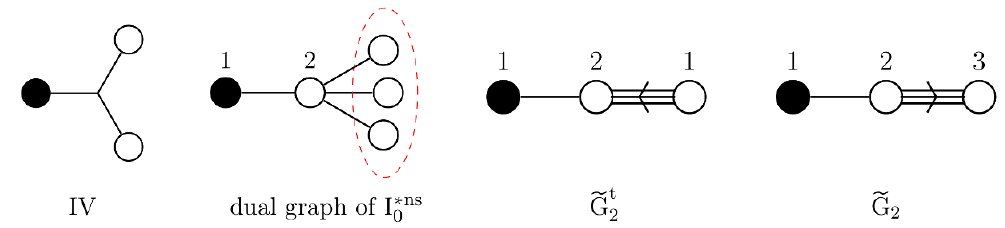
Figure 2 . Conventions for dual graphs. The black node represents the extra node of the a(cid:14)ne Dynkin diagram. The a(cid:14)ne Dynkin diagrams e G 2 and e G t e G t 2 is the dual graph of a singular (cid:12)ber over the generic point of a component of the discriminant locusof an elliptic (cid:12)brations. Speci(cid:12)cally, e G t